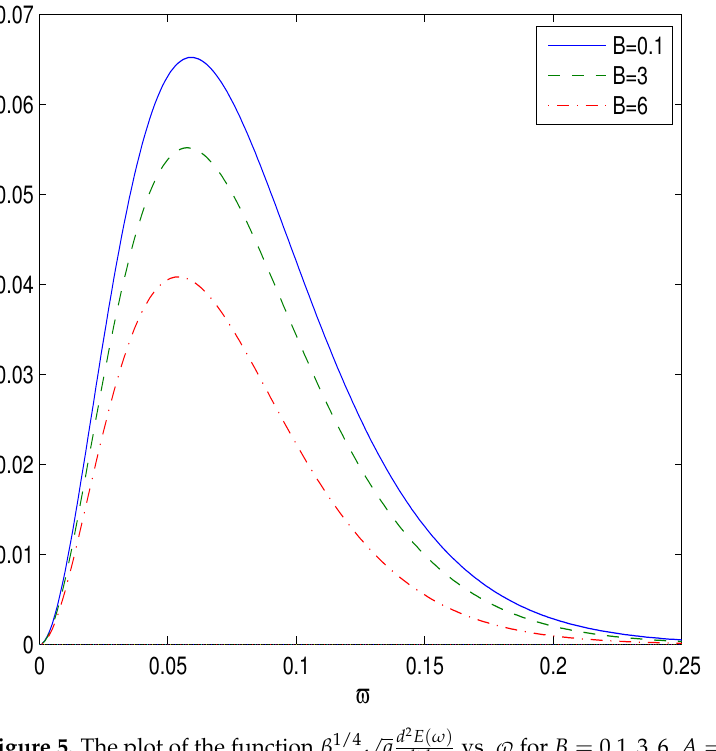
Figure 5. The plot of the function β 1/4